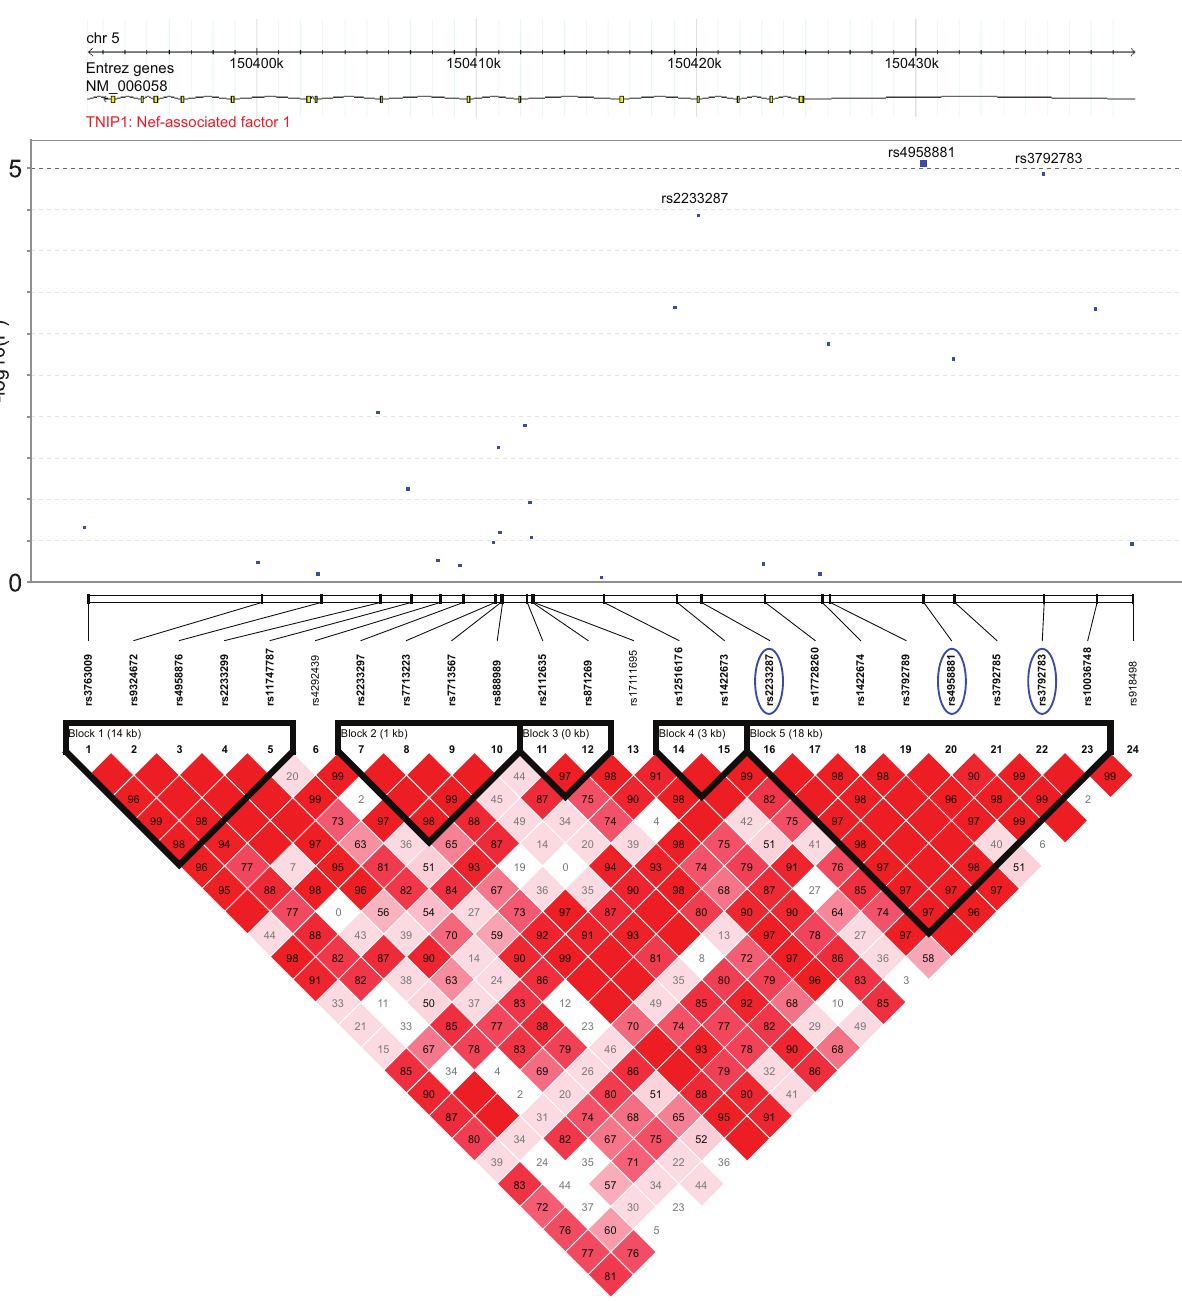
Figure 3. Association and linkage disequilibrium patterns at the TNIP1 gene. (A) Association of SNPs in TNIP1: 2 log10 P of the logistic regression test for association (y axis) in the GWAS stage of SNPs is plotted against their physical position. The continuous line corresponds to P , 10 2 5, the minimum P value of the top 7 SNPs identified in stage 1. The three SNPs that were followed and replicated in stage 2 are highlighted by a blue circle. Positions are given as NCBI build. (B) Linkage disequilibrim patterns at the TNIP1gene: pairwise LD (D 9 ) are indicated by color gradients: D 9$ 0.80, red; 0.5 # D 9, 0.8, pink; 0.2 # D 9, 0.5, light pink; D 9, 0.2, white. The 3 SNPs are in strong LD (r2=0.57/0.72 between rs3792783 and rs2233287/rs495881). Intron and exon structure of the TNIP1 gene are taken from the UCSC Genome